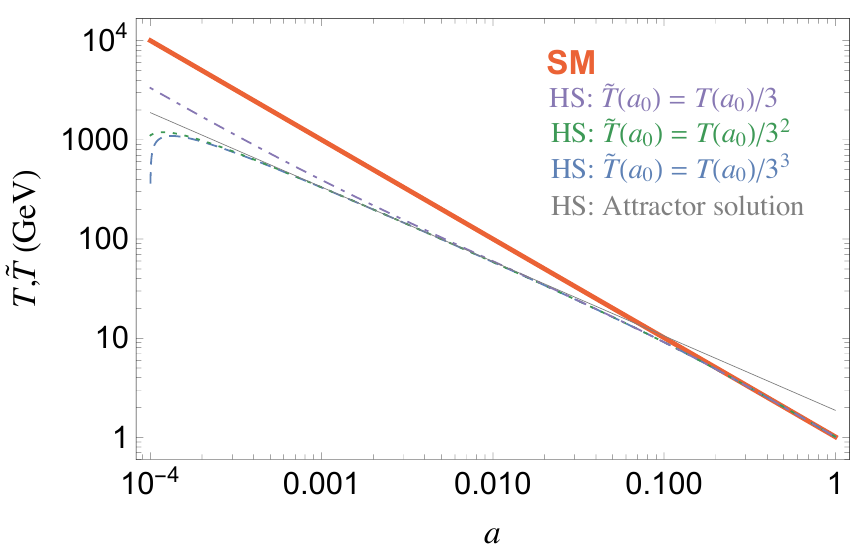
Figure 1. Evolution of SM temperature (red) and hidden sector temperature (purple, green, blue) as a function of scale factor a when the two sectors are linked by the renormalizable 2 ! 2 interaction of eqs. (2.11){(2.12). Di(cid:11)erent HS temperature solutions follow from di(cid:11)erent initial conditions at a 0 . The grey line shows the attractor ‘leak-in’ solution, ~ T / a (cid:0) 3 = 4 , of eq. (2.15). Solutions with initial conditions below the leak-in attractor rapidly converge to it, while the solution that starts at a higher temperature than the leak-in solution redshifts until it matches onto the attractor. The two sectors equilibrate near a = 0 :